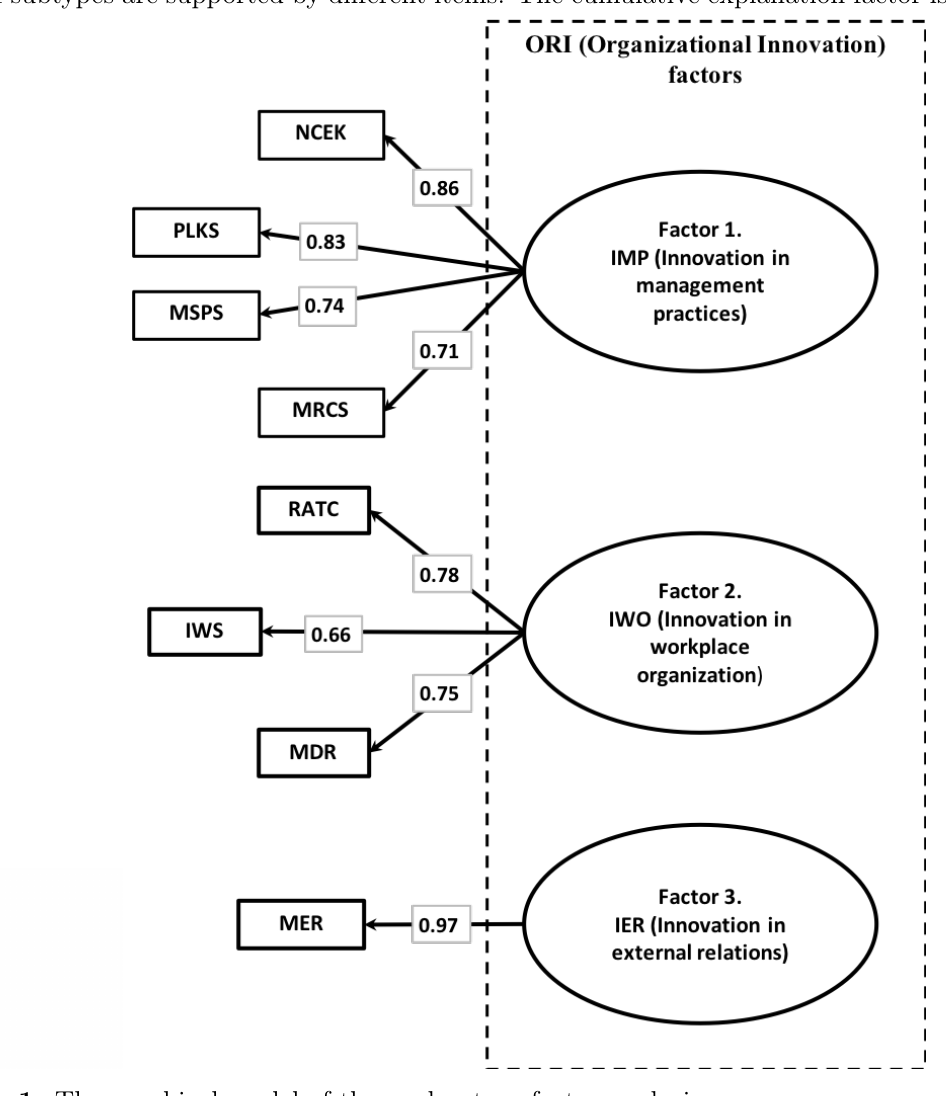
Fig. 1. The graphical model of the exploratory factor analysis To test the hypotheses for the factorial validity of the identified factors, a confirmatory factor analysis was carried out. The results of an exploratory factor analysis (3 factors, 8 items)